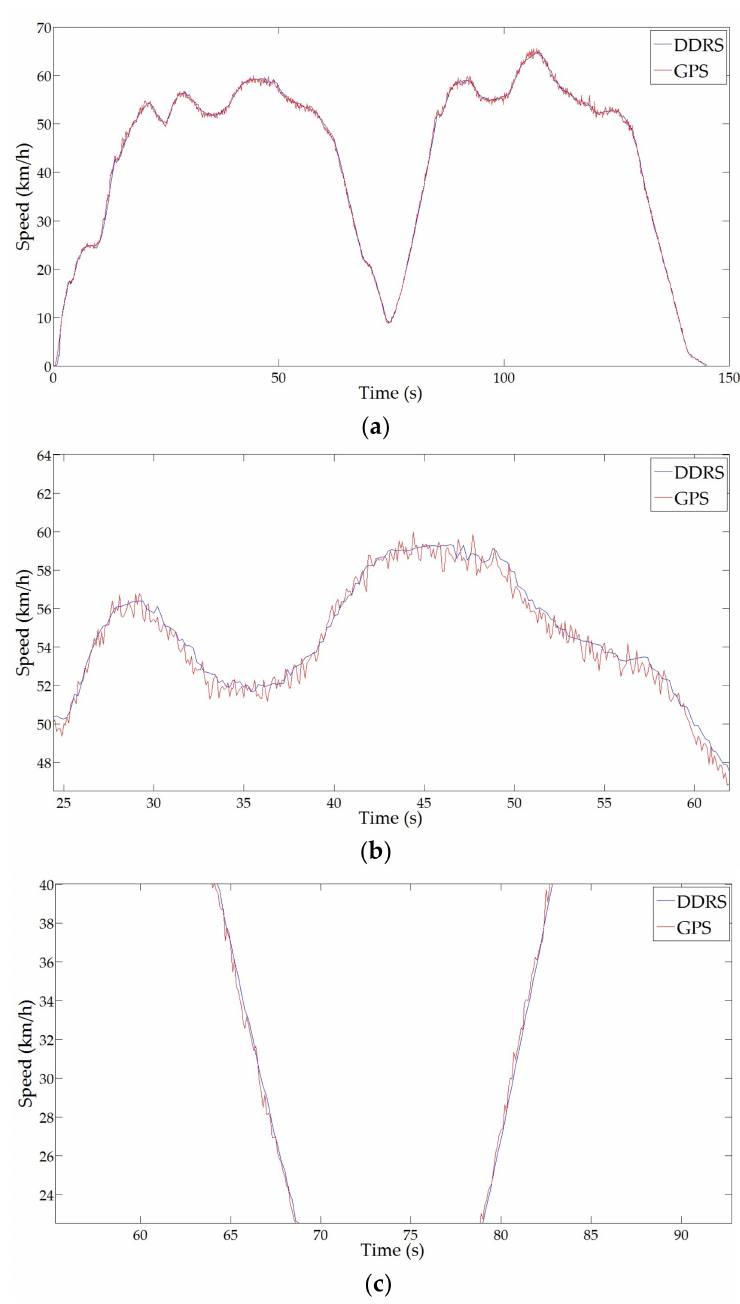
Figure 14. Experimental results. ( a ) Overview; ( b ) deviations in speed variation; ( c ) deceleration and